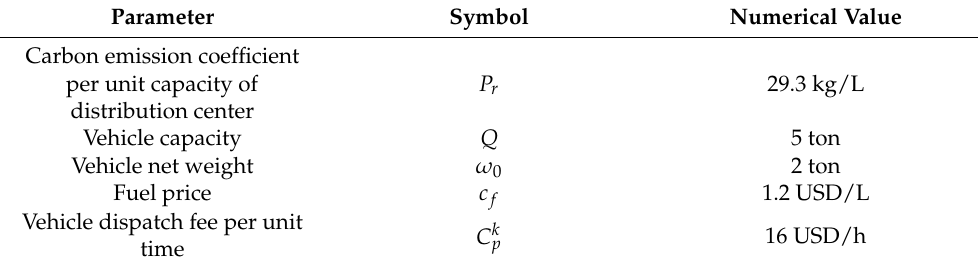
Table 5. The example parameters.